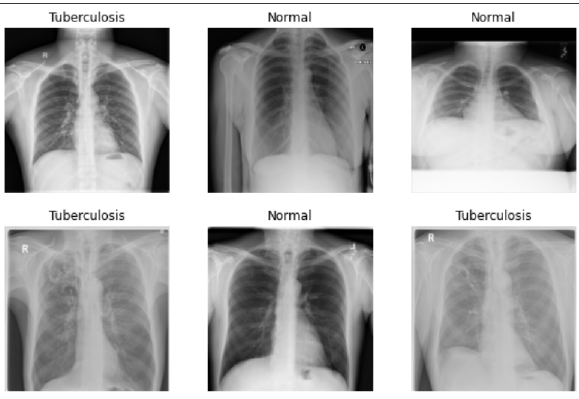
Figure 1. Chest X-ray dataset with the labels